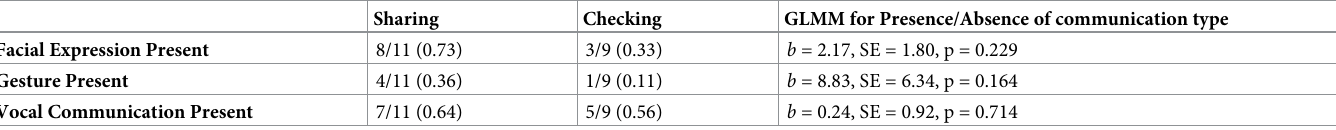
Table 4. The proportion of high agreement Sharing and Checking looks (as judged by the raters) in which the infant produced at least one facial expression, gesture, and vocalisation during the look to their mother, and results from the GLMM analyses. Sharing Checking GLMM for Presence/Absence of communication